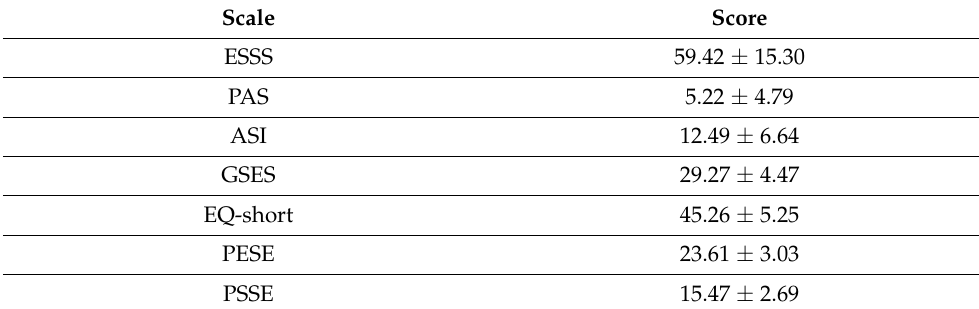
Table 1. Mean scores ± standard deviation for each administered scale.